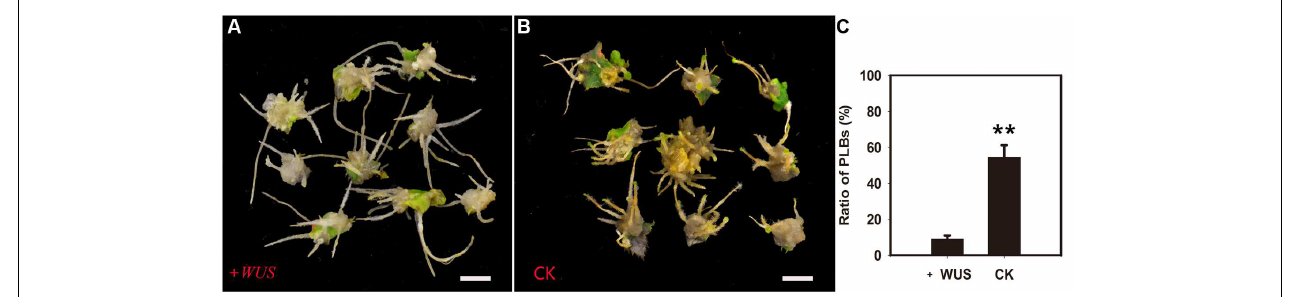
FIGURE 7 | Overexpression of RcWUS had little effect on PLB formation. The leaves of XVE::WUS transgenic plants were used to produce callus-rhizoids according to Tian et al. (2008), which were then transferred to PIM that was supplemented or not with β -estradiol. (A) PLB formation was repressed by overexpression of RcWUS on PIM supplemented with 5 µ M β -estradiol in transgenic line #8. (B) PLBs formed normally on PIM supplemented with 5 µ M ethanol in transgenic line #8. (C) Percentage of PLB formation after culture in light for 9 days. Error bars represent the SE of three biological replicates. Asterisks indicate highly significant differences calculated using the t -test ( ∗∗ P < 0.01) ( n = 9–12 for each